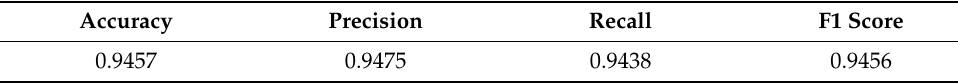
Table 6. Model training results for the second scenario.